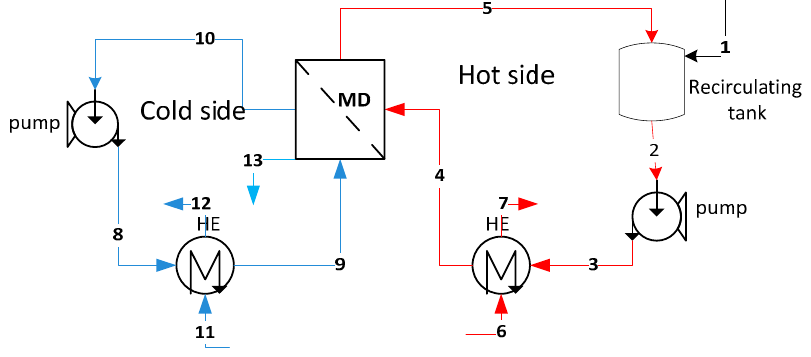
Figure 2. The Xzero AGMD unit used and the different streams considered.